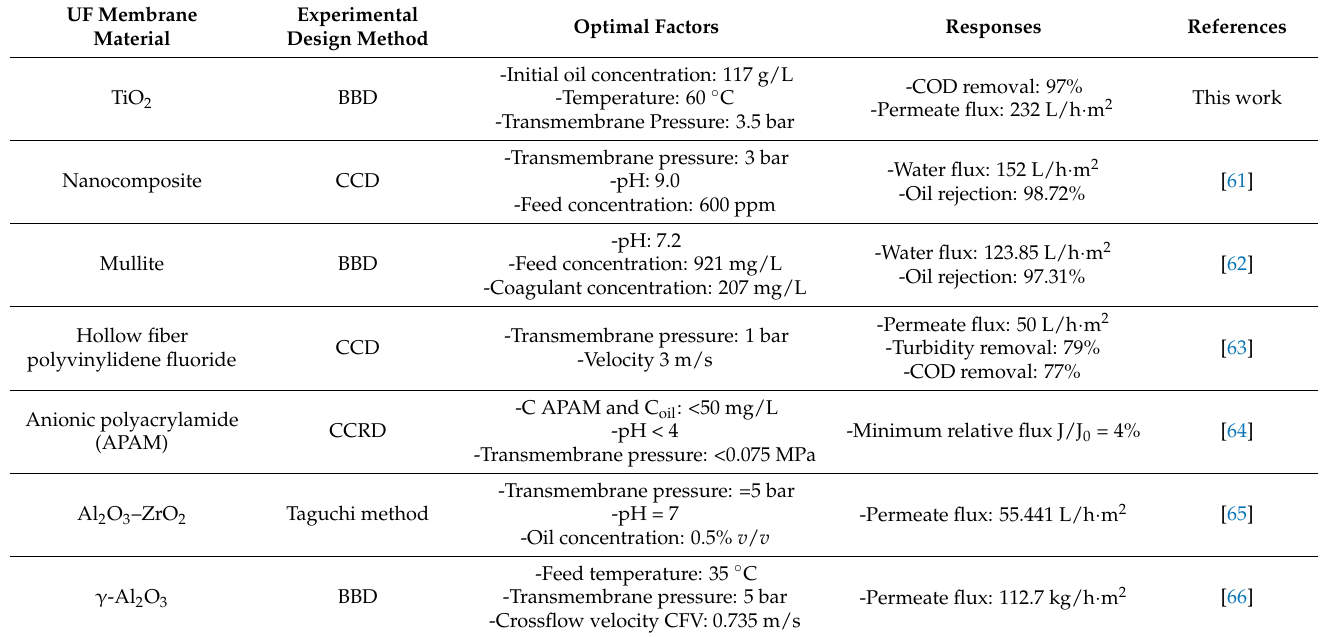
Table 6. Comparison of the UF membrane, optimization method, optimal factors, and responses.